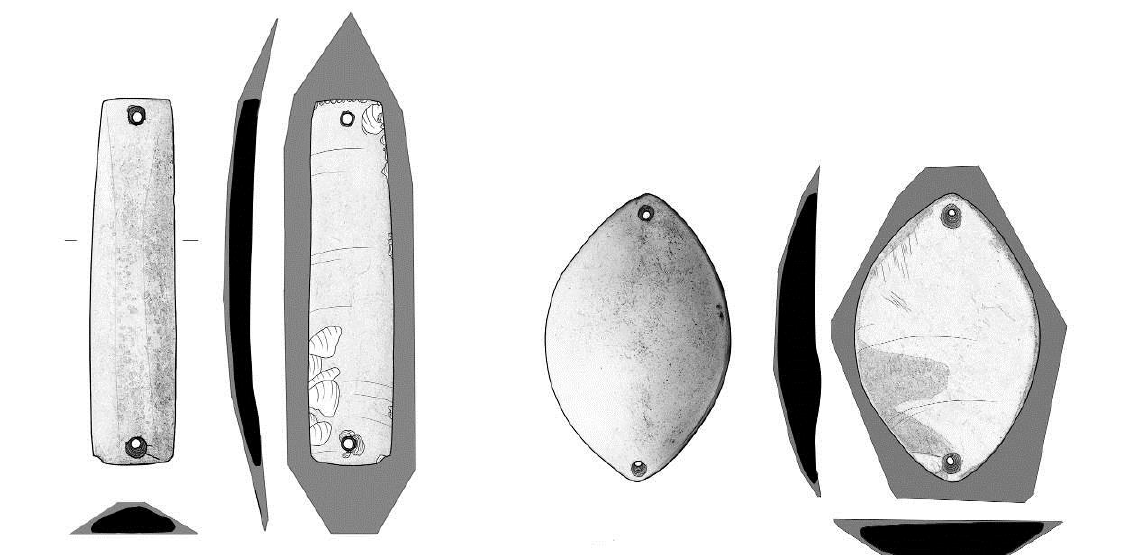
Figure 11. Schematic diagram to indicate the size of the original blade or flake that likely would have been needed to make a rectangular link, A905g 60.7 x 15.5 x 3.5 mm and an oval link A909j 51.7 x 36,1 x 7.8 mm (source Elizabeth Healey; drawing of links S.